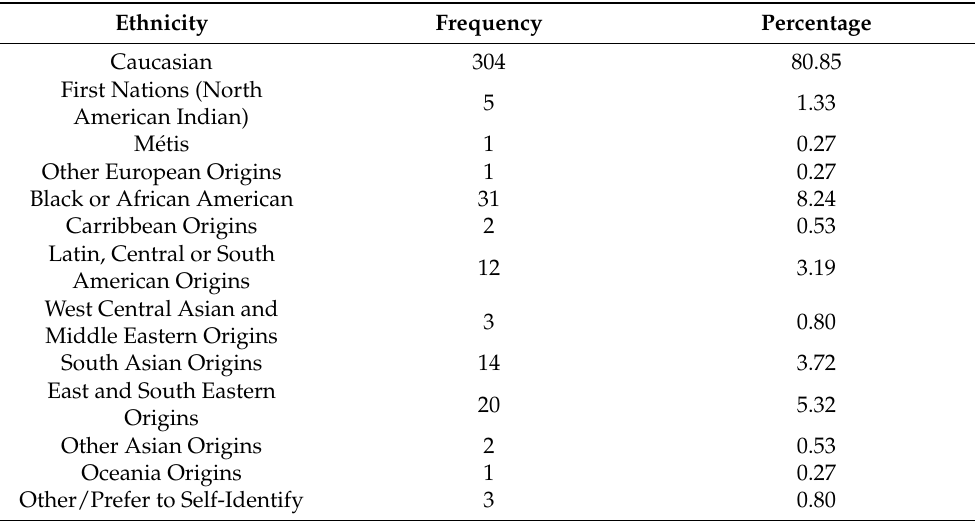
Table 1. Participants’ self-reported